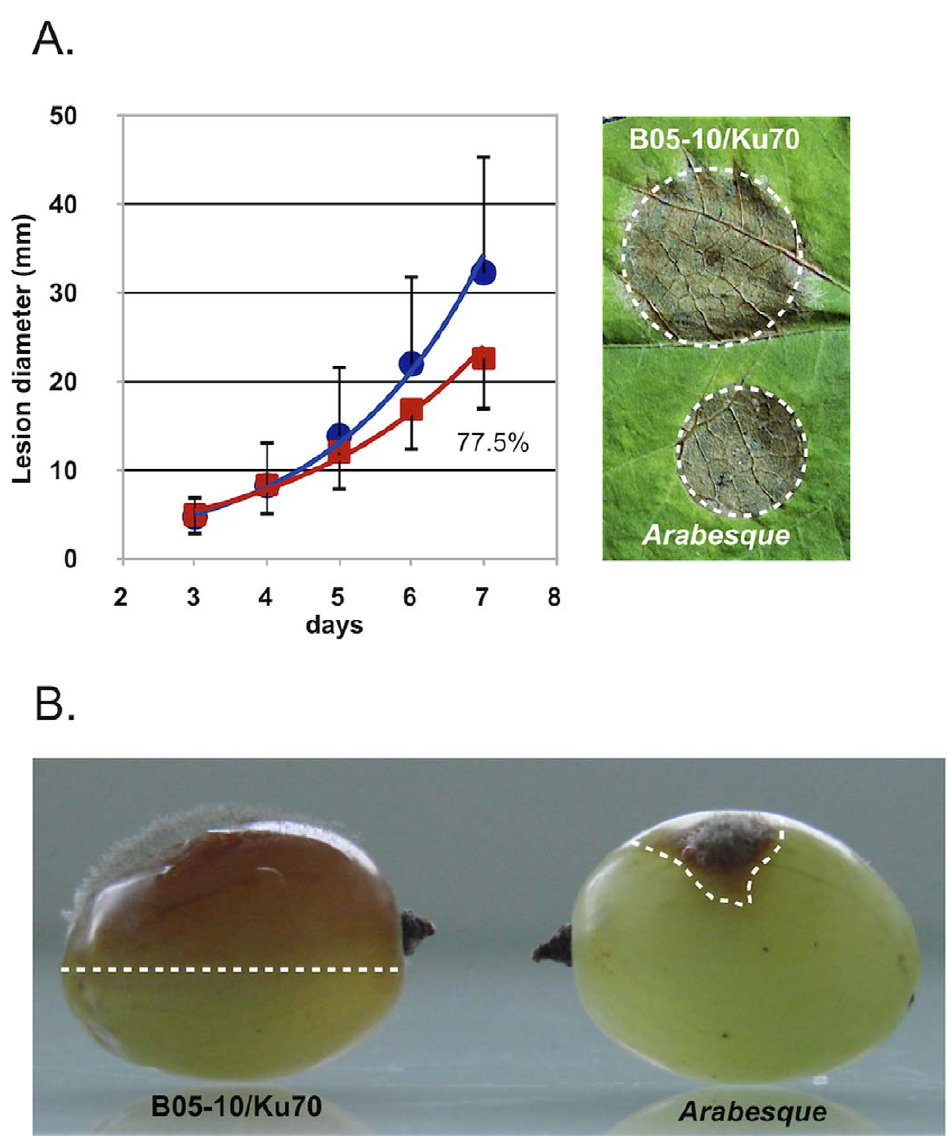
Figure 5. Impact of the BcHOX8 mutation on conidia-derived infection. Kinetic of green bean leaves infection by the parental B05-10/ D ku70 (circle) and the Arabesque mutant B05-T 70-1 (square) strains using conidia droplets as inoculum. Three independent experiments using 6 leaves each were performed. Linearization of the exponential curves allowed calculation of the relative mutant growth when compared to its parent (% of the slope obtained for the parental strain). A 7-days infection picture is shown. (B) Grape berries infection by the parental and Arabesque mutant strains using conidia as inoculum; a comparative 7-days infection picture is shown.